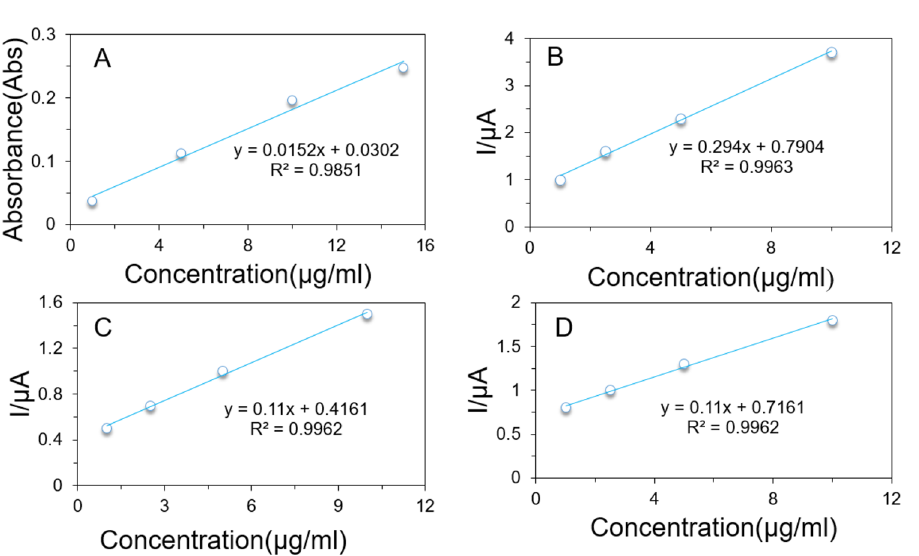
Figure 1. Calibration curve for measuring drug loading efficiency by using UV–Vis spectroscopy ( A ). Calibration curve for evaluating drug release percentage by using the electrochemical sensor at pH 3.5 ( B ), pH 7.4 ( C ), and pH 9.0 ( D